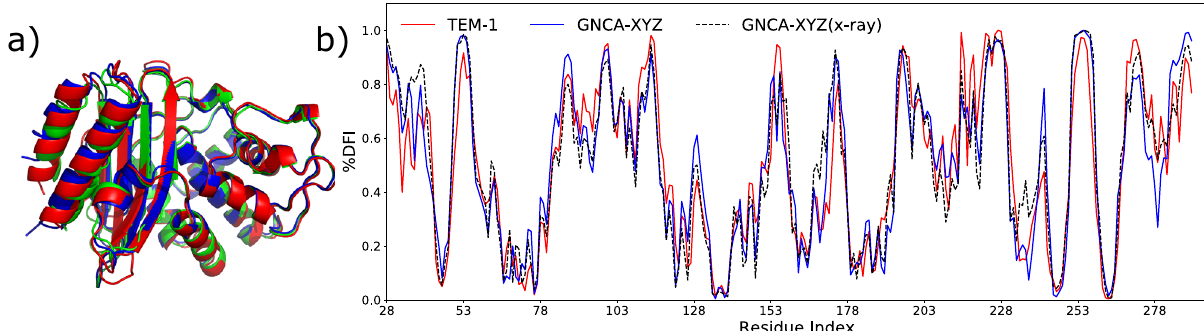
Fig. 5 GNCA-XYZ structure obtained through X-ray crystallography reproduces predicted fl exibility pro fi le. a Superimposing the cartoon representation of the crystal structure of GNCA-XYZ (blue) obtained from X-ray crystallography over the wild-type GNCA (green) and TEM-1 β -lactamase (red) shows that it shares the same 3D fold as the wild-type proteins (RMSD <1 Å). b Comparing the DFI pro fi le of the mutant GNCA-XYZ calculated through the dynamics from an MD simulation starting from the crystal structure obtained by X-ray crystallography (black broken line) with the DFI pro fi le of the wild-type TEM-1 β -lactamase (red). We observe that the mutant, as predicted (blue), is able to successfully mimic the rigid regions of TEM-1 β - lactamase, and also its fl exible regions with remarkable accuracy. Moreover, the DFI pro fi le of the mutant calculated using the structure obtained through X-ray crystal also matches with our prediction obtained by the mutations performed computationally. This shows the relative robustness of the computational procedure followed in the analysis. The computed data are provided as a Source Data fi le.